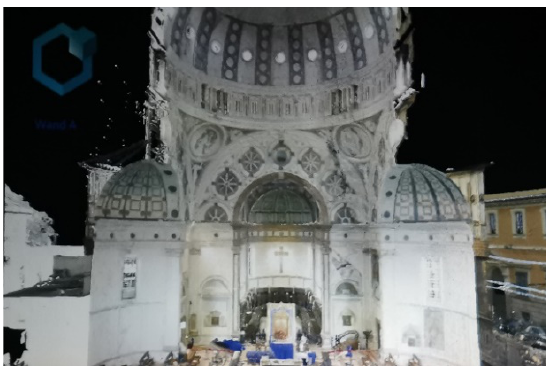
Figure 7 . Interior visualization of Santa Maria delle Grazie main dome. Source: external projector.